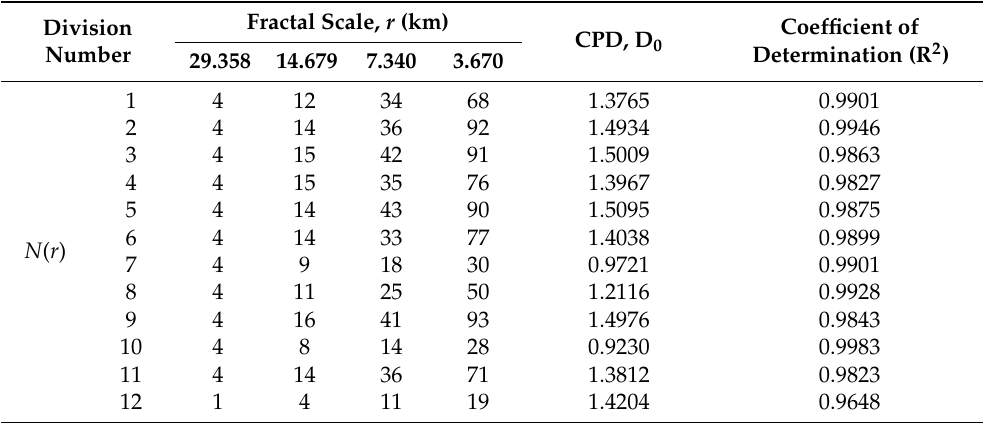
Table 3. Statistical table of division for the capacity dimension (CPD) calculation parameters.